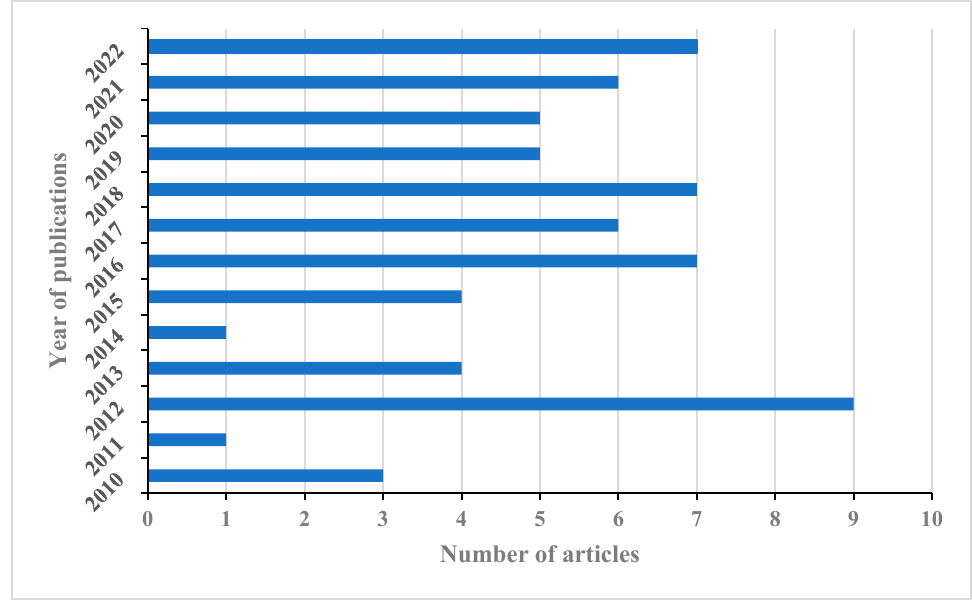
Figure 1. Number of papers published tracking renewable energy transition within Canadian communities (by April 2023).